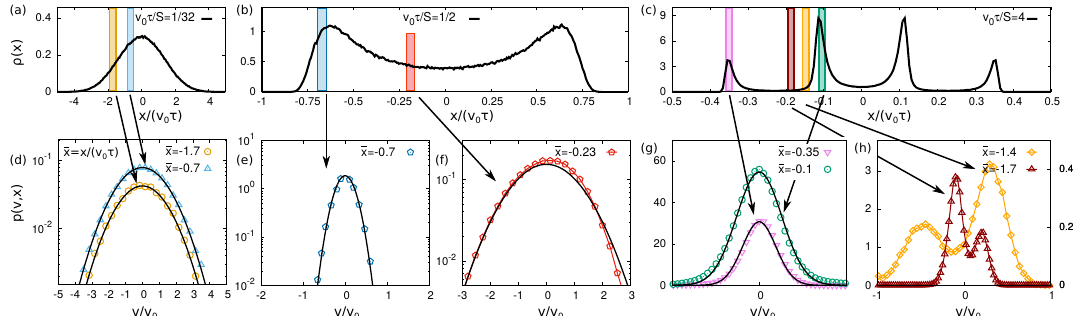
Figure 3: Velocity distributions. Panels (a), (b) and (c): simulated density distribu- τ ) = 32,2,1 / 4, respectively, as a reference. Colored rectangles tion ρ ( x ) for S / ( v 0 are drawn in correspondence of the spatial regions used to calculate the velocity dis- tribution in the other panels. Panels (d), (e), (f), (g) and (h): velocity distribution τ according to the leg- p ( v , x ) as a function of v calculated at fixed positions x = ¯ xv 0 end. Panel (d) is calculated at S = 32, panels (e) and (f) at S = 2 and panels (g) and (h) at S = 0.25. Colored symbols and lines are obtained by numerical simulations and solid black lines show the theoretical prediction (9) if applicable (the theory yields a one-dimensional Gaussian and requires a positive definiteness of Λ ( x ) given by Eq. (19)). Simulations are realized in one spatial dimension with τ k /γ = 1 and α =